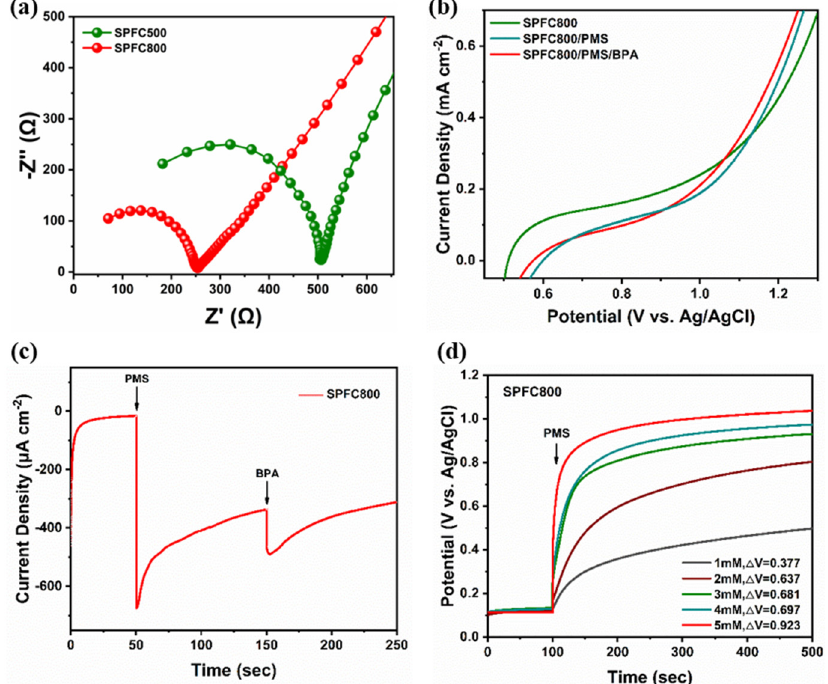
Figure 6. Electrochemical impedance spectroscopy (EIS) of SPFC500 and SPFC800 ( a ); linear sweep voltammetry (LSV) of SPFC800 with/without PMS and BPA ( b ); I-T curves after adding PMS and BPA ( c ); and the change of SPFC800 potential with injection of different concentrations of PMS ( d ).